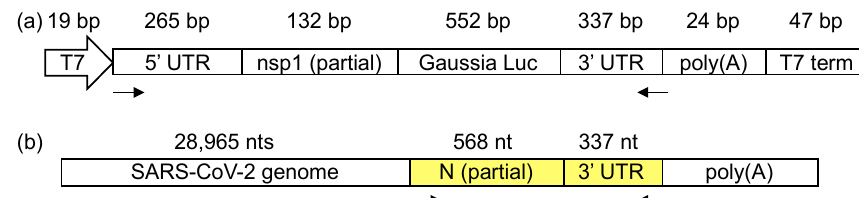
Figure 1. ( a ) The SARS-CoV-2 minigene construct containing the 5 ′ and 3 ′ untranslated regions (UTRs) and a short poly(A) tail. ( b ) The amplicon location (highlighted in yellow) in the SARS-CoV-2 genome for the in-virion DMS-MaPseq. The arrows indicate the primer-binding sites for the amplicons.